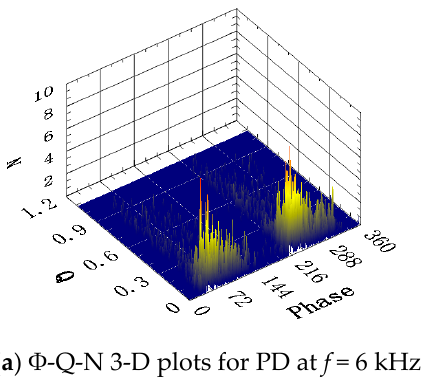
Figure 9. Typical PD plots at f = 6 kHz.